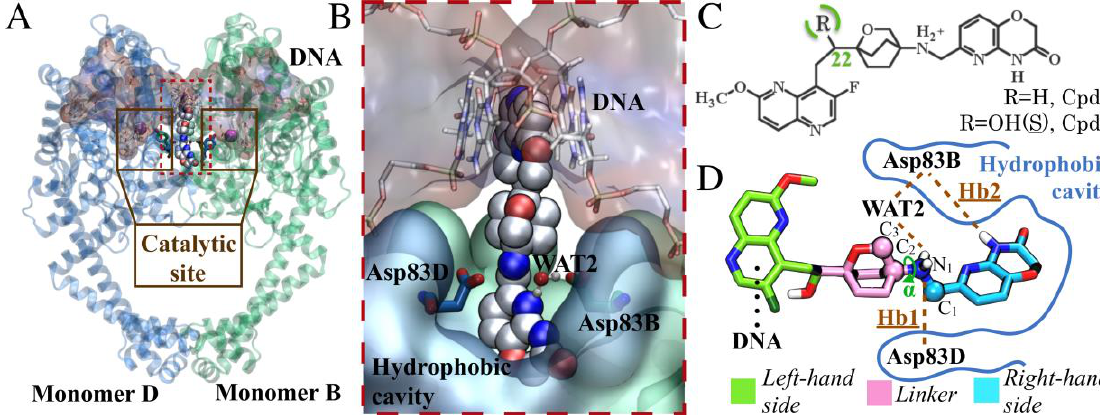
Figure 1. ( A ) Representation of the GyrA-GyrB truncated core fusion (PDB 4PLB). This structure contains monomer B and monomer D, which are shown in green and blue, respectively. The DNA is represented as red surface. The two maroon boxes enclose the protein’s catalytic site. AM8191 (Cpd2) is displayed in white carbons, WAT2 in CPK representation, and Mg 2+ as purple spheres; ( B ) Binding mode of Cpd2 into DNA gyrase; ( C ) 2D representation of the NBTIs studied, Cpd1 and Cpd2, in their protonated state, as in our simulations; ( D ) Scaffold classification for Cpd2, showing the left-hand side (LHS) in green, the linker in pink, and the right-hand side (RHS) in light blue.